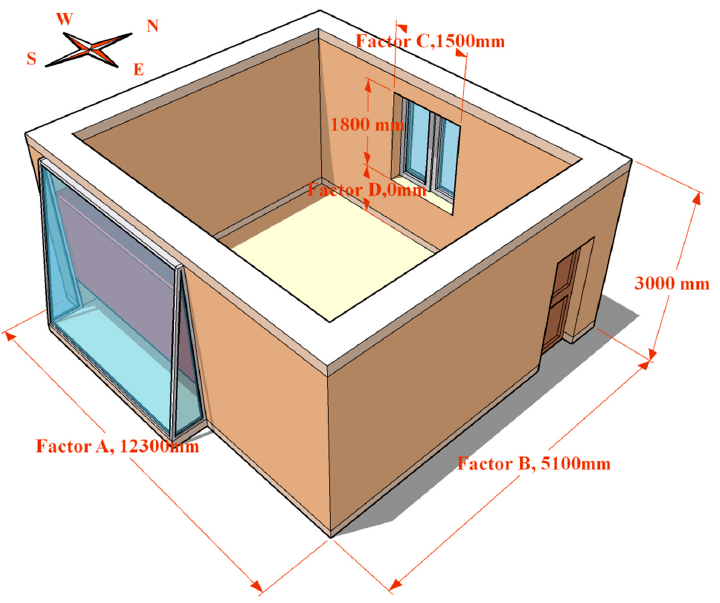
Figure 10. The configuration parameters of the room corresponding to the optimal combination.